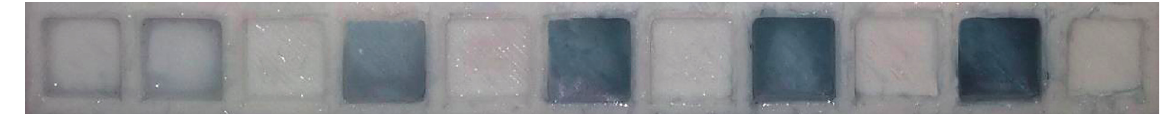
Figure 7: An example of assay cut of a photograph where one row composed from 11 wells is depicted. While wells 1, 3, 5, 7, 9, and 11 served for control purposes, and wells 2, 4, 6, 8, and 10 were used for an assay of carbofuran.